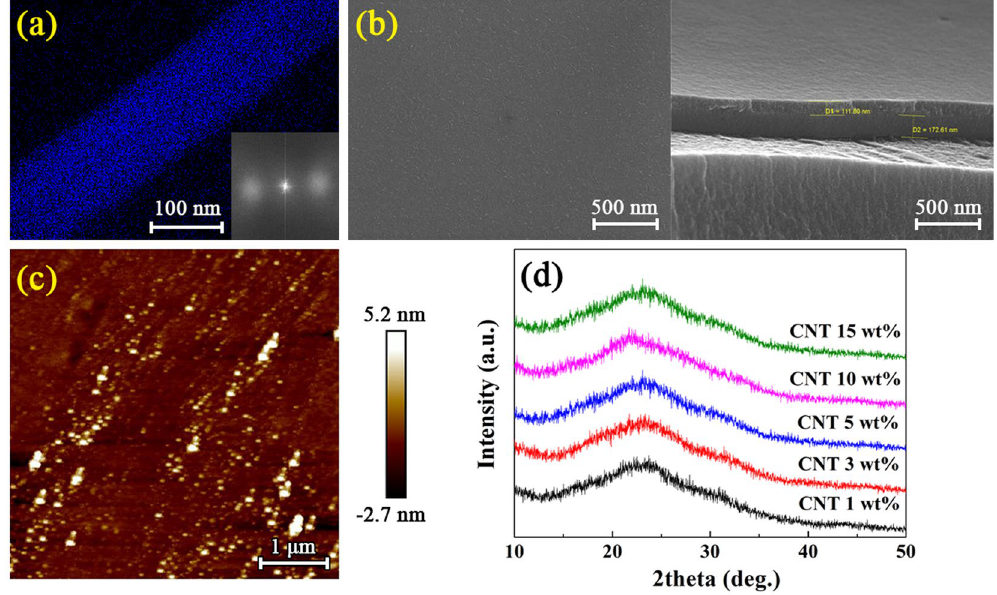
Figure 2. ( a ) TEM, ( b ) SEM, and ( c ) AFM images of the fluorocarbon thin films deposited using a 5 wt% CNT composite target, and ( d ) XRD patterns of the fluorocarbon films for various CNT/PTFE composite targets. The inset of ( a ) is the Laue diffraction image.